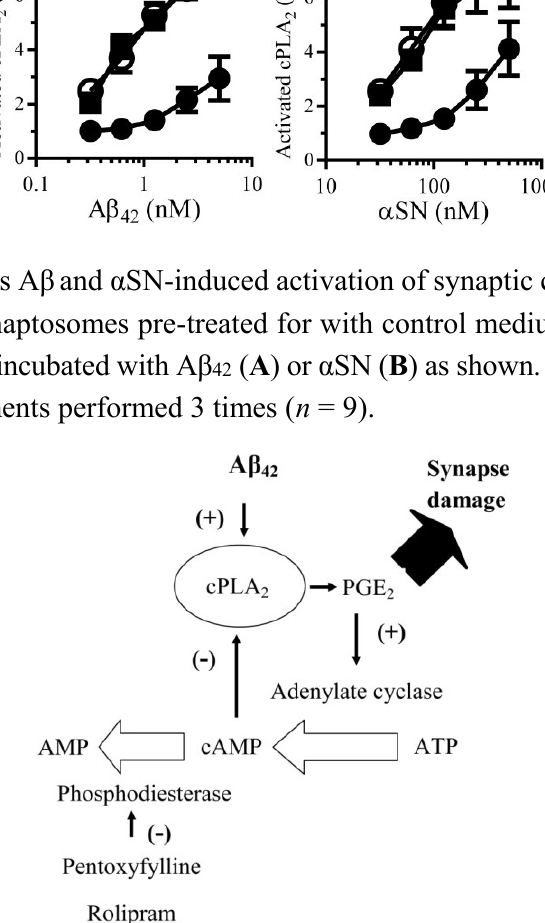
Figure 9. Feedback inhibition of cPLA 2 by cAMP: Cartoon showing the proposed inhibitory feedback system that regulates the activation of cPLA 2 in synapses. The presence of Aβ activates cPLA 2 leading to the production of PGE 2 high concentrations of which cause synapse damage. However, PGE 2 also increases concentrations of cAMP which in turn inhibits the activation of cPLA 2 completing an inhibitory feedback system. In control synapses cAMP is degraded by PDEs. Inhibition of PDEs by either pentoxifylline or rolipram results in higher concentrations of cAMP within synapses. Higher cAMP concentrations have a stronger inhibitory feedback signal and reduce the Aβ-induced activation of cPLA 2